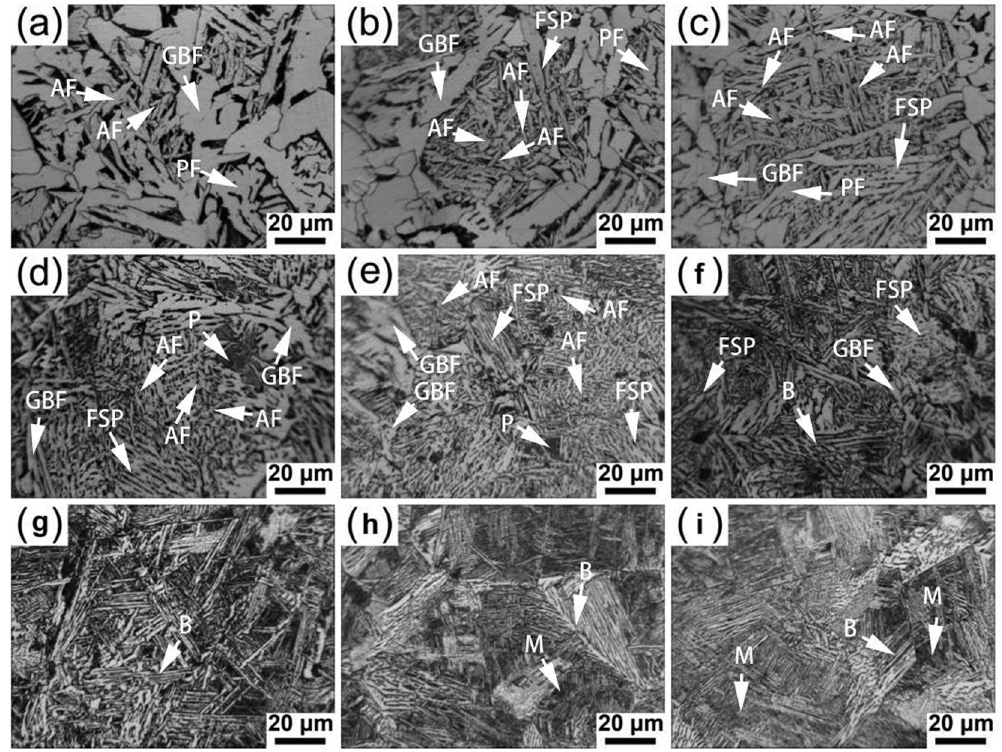
Figure 3: The microstructures of steel no. 2 under different cooling rates. ( a ) 1°C/s, ( b ) 2°C/s, ( c ) 3°C/s, ( d ) 5°C/s, ( e ) 8°C/s, ( f ) 10°C/s, ( g ) 15°C/s, ( h ) 25°C/s, and ( i )